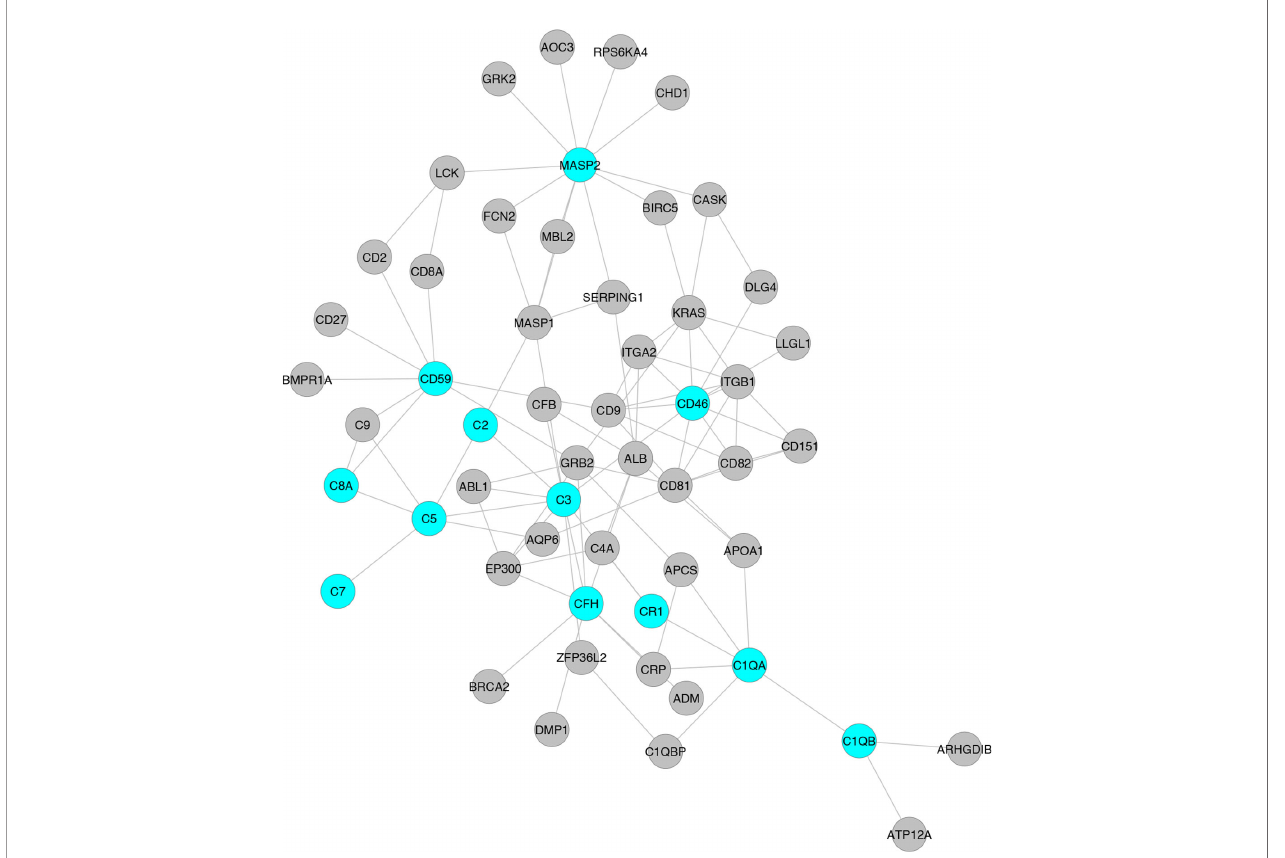
FIGURE 5 | Protein-protein interaction network analysis identi fi es biological relatedness of complement components to regulators of hepatocellular carcinoma (HCC) pathogenesis. Complement molecules of relevance to HCC were subjected to protein-protein interaction (PPI) network analysis using the network-based gene prioritization algorithm, ToppGenet of the ToppGene Suite (http://toppgene.cchmc.org). ToppGenet identi fi es and prioritizes candidate genes based on functional annotations, similar expressions, and network and topographical features. A Step Size of 6 and the Prioritization method of k-Step Markov were used as default analytical parameters. The Cytoscape-compatible ToppGenet output fi le was used to generate the graphical network. The fi rst shell of 41 interacting proteins (grey color) associated directly with the input complement proteins (blue) in the PPI were generated by